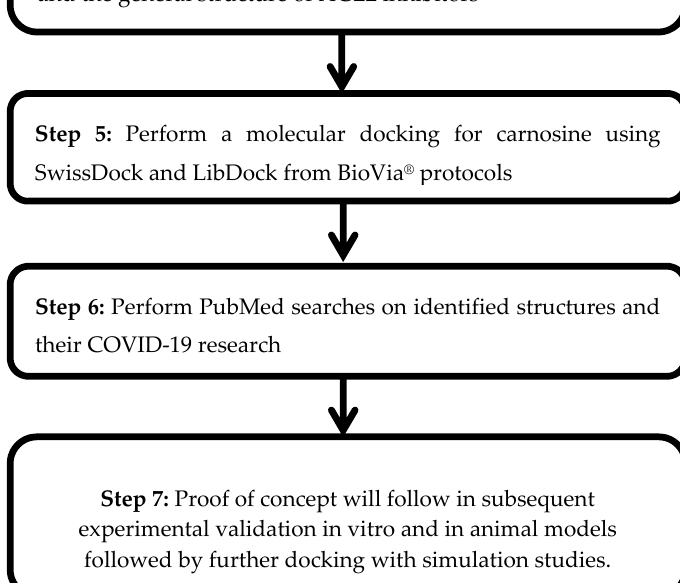
Figure 1. Overview of the study methodology.